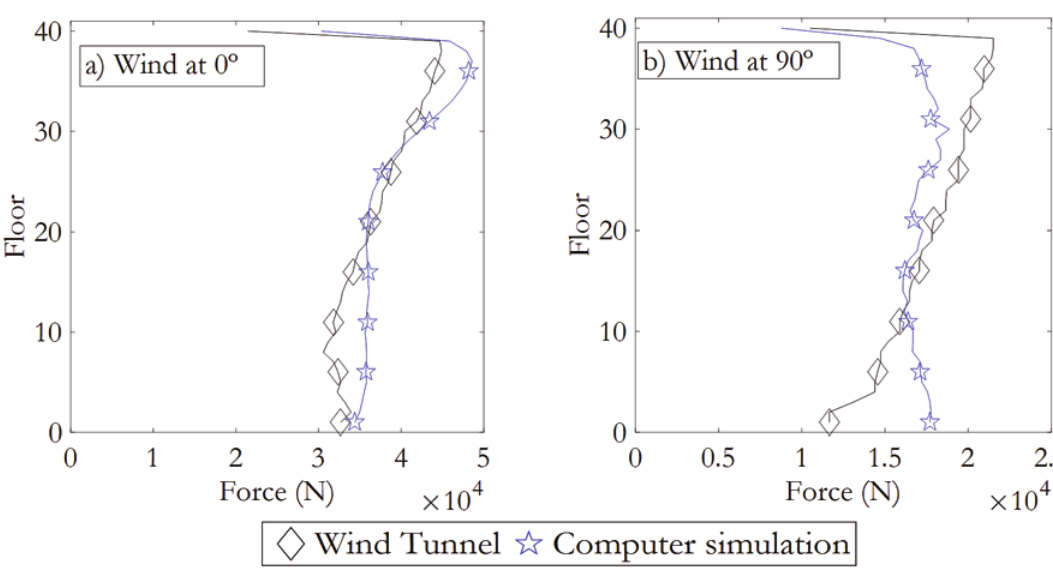
Figure 15 Drag force per floor: CFD and wind tunnel - wind incidence: a) j = 0° and b) j